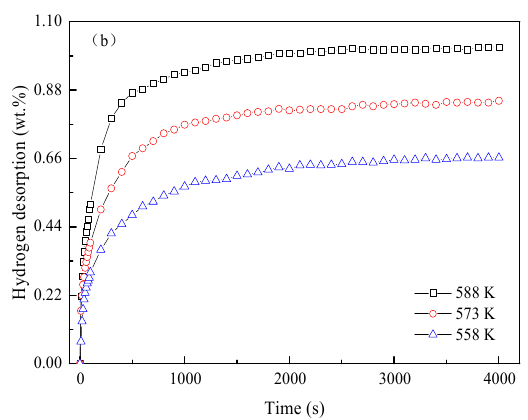
Figure 6. Kinetics of the La 7.0 Mg 75.5 Ni 17.5 alloy at different temperatures: ( a ) hydriding processes, ( b ) dehydriding processes.